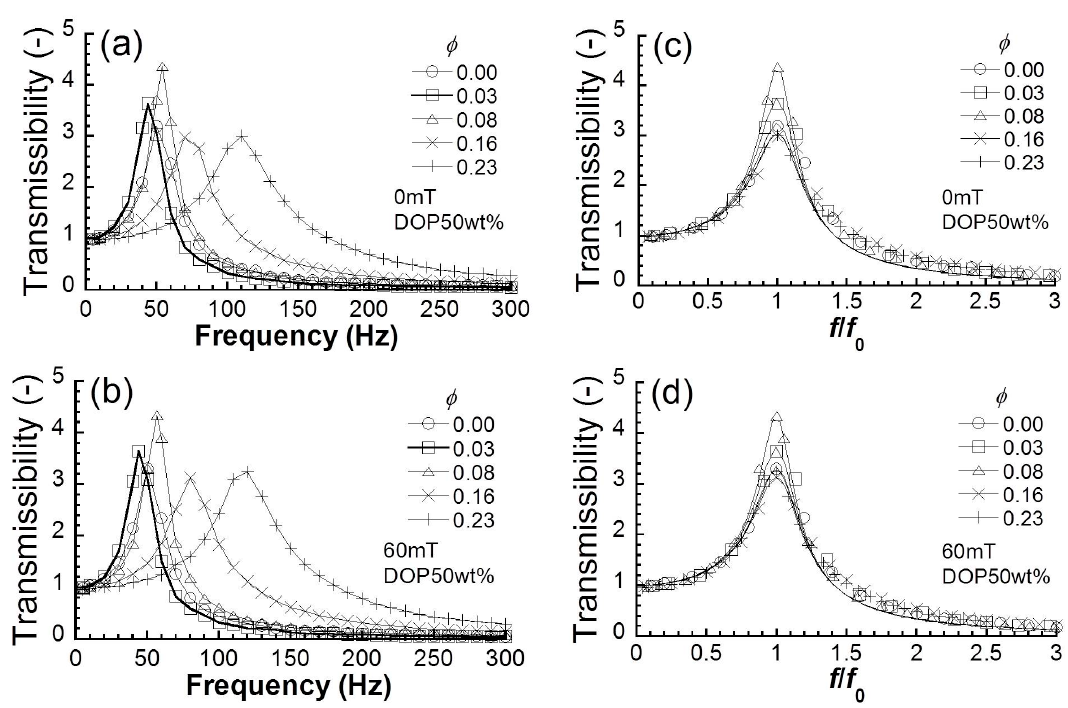
Figure 2. Frequency spectra of transmissibility for magnetic elastomers with various volume fractions of magnetic particles at ( a ) 0 mT and ( b ) 60 mT. Normalized frequency spectra for magnetic elastomers at ( c ) 0 mT and ( d ) 60 mT (loading weight 69 g).